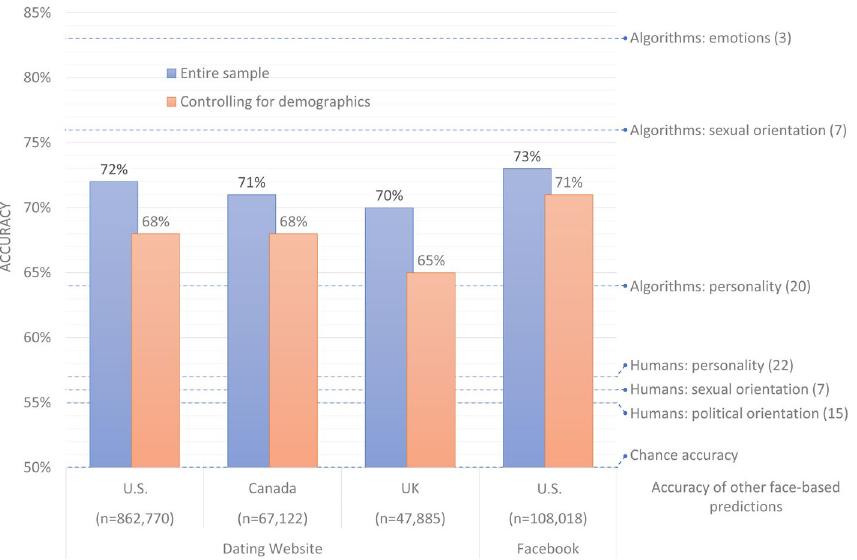
Figure 2. Accuracy of the facial-recognition algorithm predicting political orientation. All 95% confidence intervals are below 1% and are thus omitted. Humans’ and algorithms’ accuracy reported in other studies is included for context.